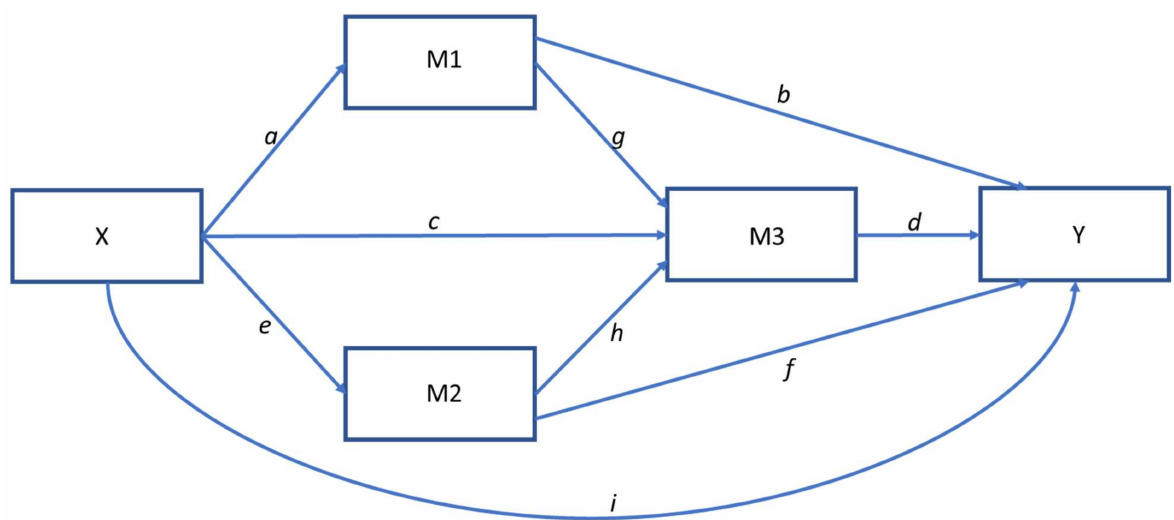
Figure 2. Hypothesized mediation path model for SCIAM. Model includes nine direct paths ( a – i ) with two parallel mediators (M1 and M2) that are serially antecedent to a third mediator